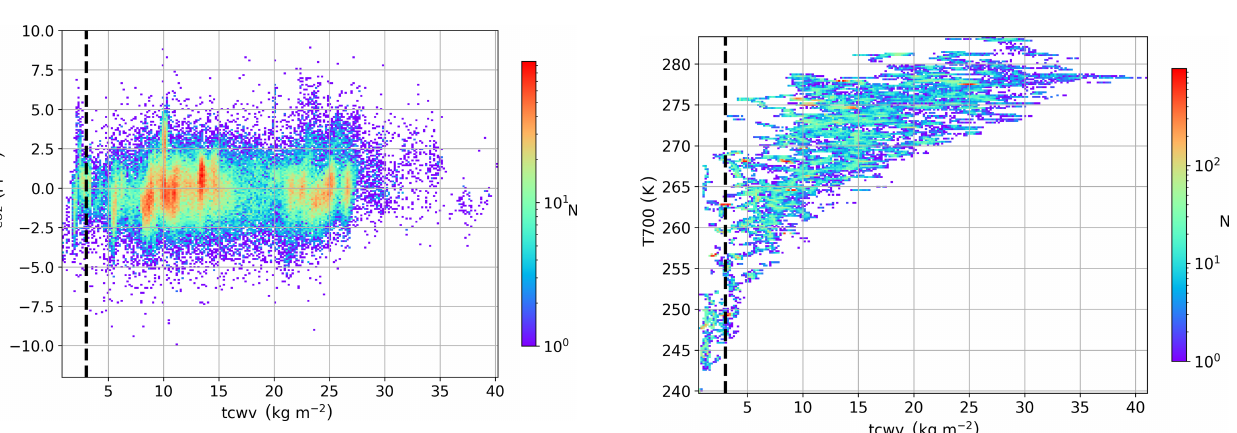
Figure 21. Bias in coincident retrievals of X CO – NNG), with all boreal QC filtering except the bound on total col- umn water vapor (tcwv) against retrieved tcwv, plotted as a density map. The lower bound placed on tcwv in the boreal QC (3kgm − 2 ) is shown as a black dashed vertical line.